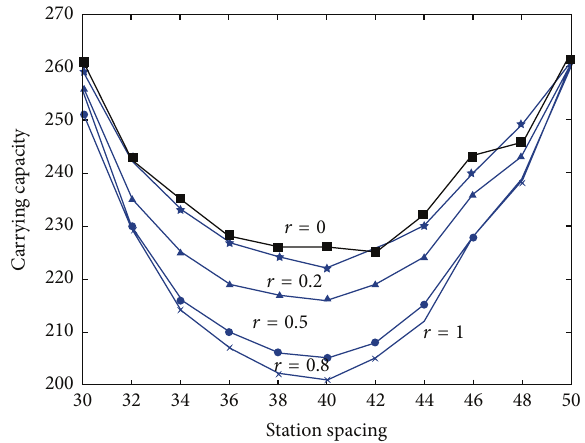
Figure 2: The influence on carrying capacity by mixture ratio. Figure 3: The influence on carrying capacity by station spacing in different mixture ratio ( 𝑟 represents the ratio of number of the express-train compared with that of the lower-speed